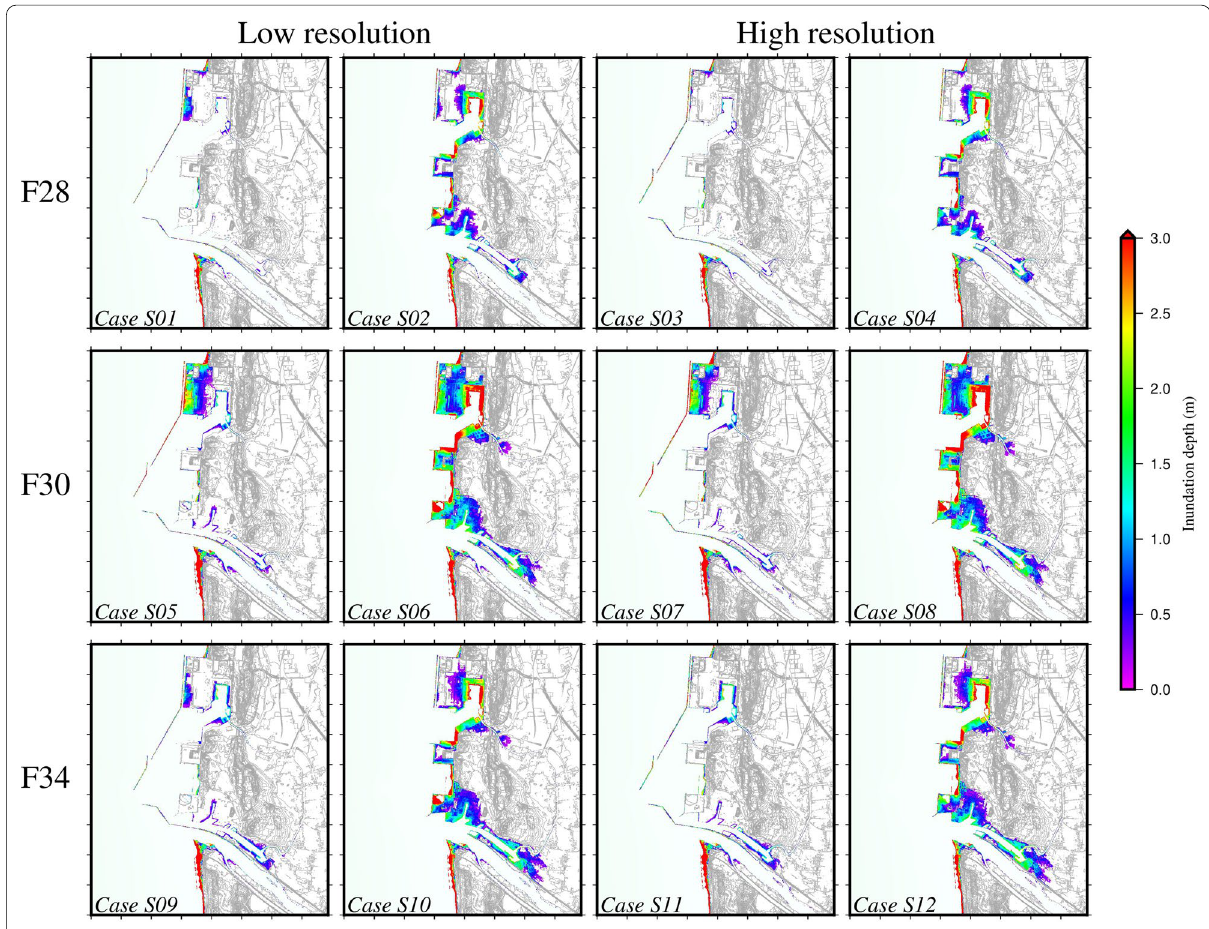
Fig. 9 Distribution of the maximum inundation depth at Sakata City generated up to 45.0 min after the earthquakes. The displayed areas correspond to the areas specified by the blue squares in the middle-right panel in Fig. 3; the thick interval was 1